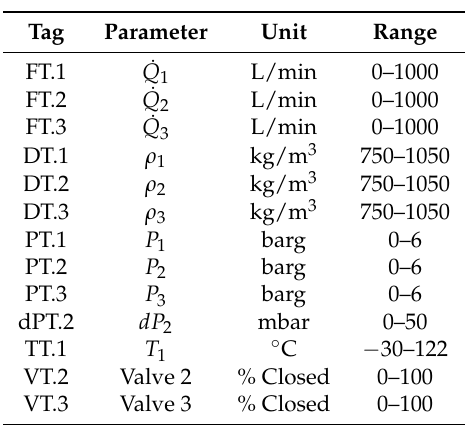
Table 2. Recorded